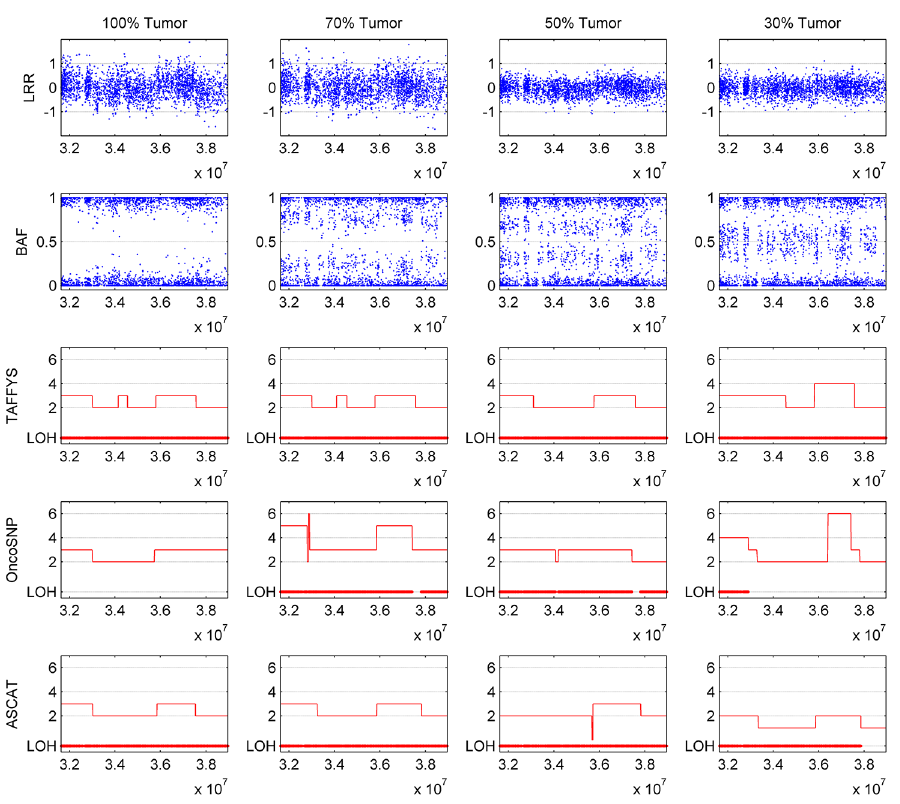
Fig 5. Comparison of results for lung tumor H1395 by different methods. Copy number and LOH results for chromosome 15 of four dilution samples with 100%, 70%, 50% and 30% cancer cells were generated by TAFFYS, ASCAT, and